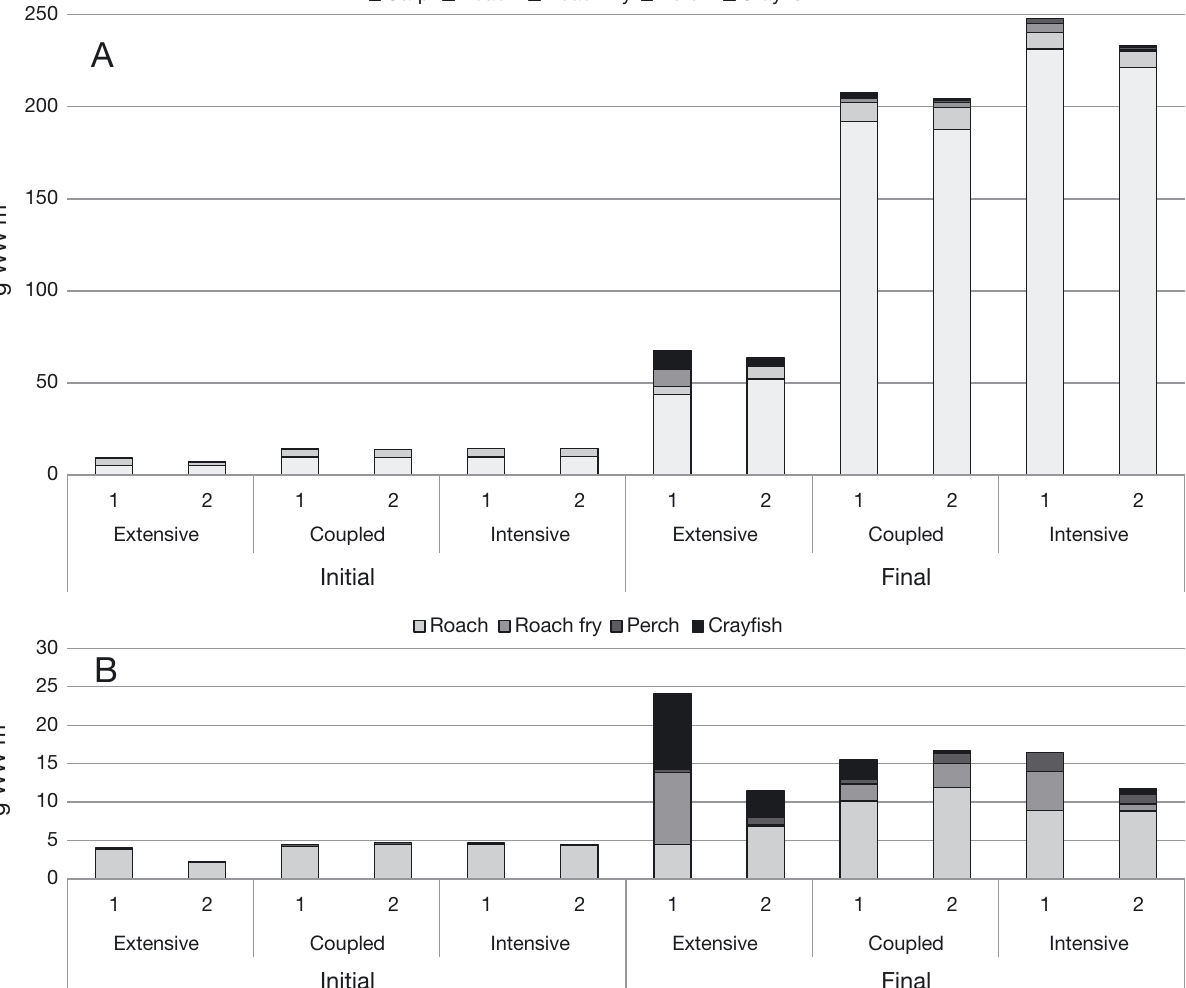
Fig. 1. Fresh biomass per surface unit (g wet weight m −2 ) of the different reared species at stocking (initial) and harvesting (final). (A) all reared species; (B) all species without common